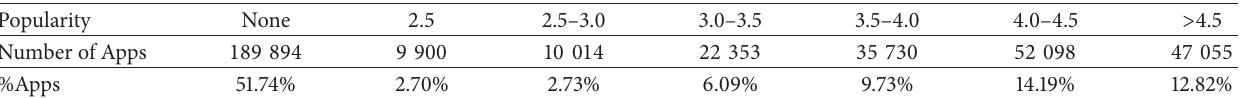
Table 4: Initial distribution of Apps by popularity in July 2011 in the nonofficial market. The percentages are the same as in the official market, Table 1.